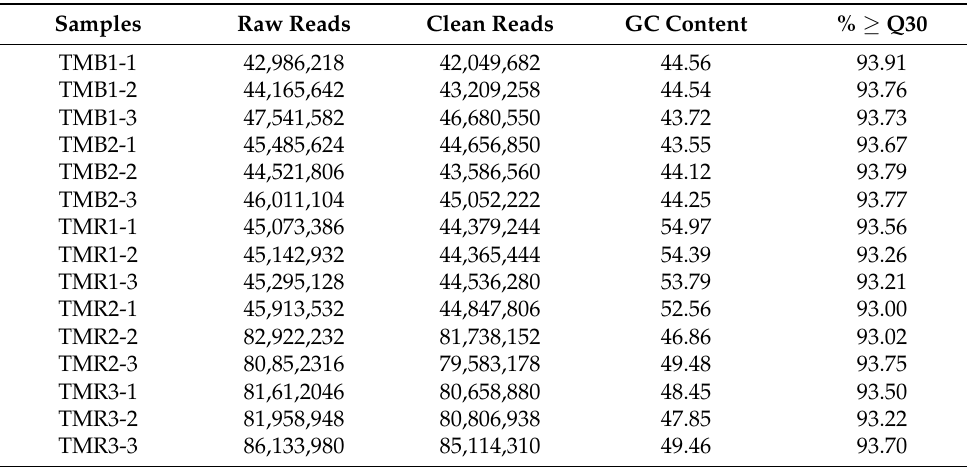
Table 1. Statistical summary for all RNA-seq samples.